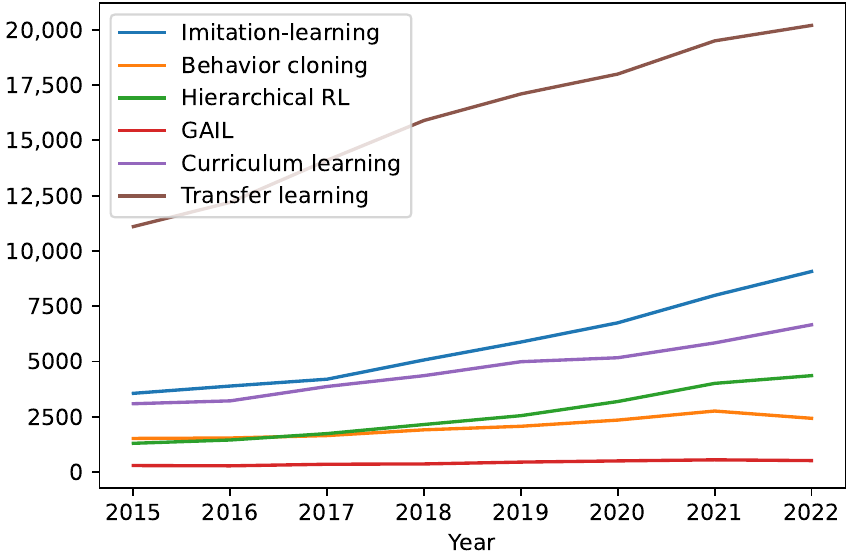
Figure 9. The trend of published papers using different reward engineering in robotic